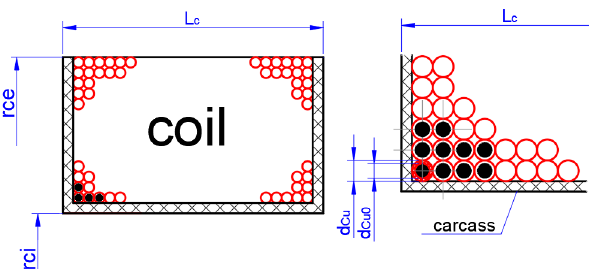
Figure 3. Dimensions of coil and